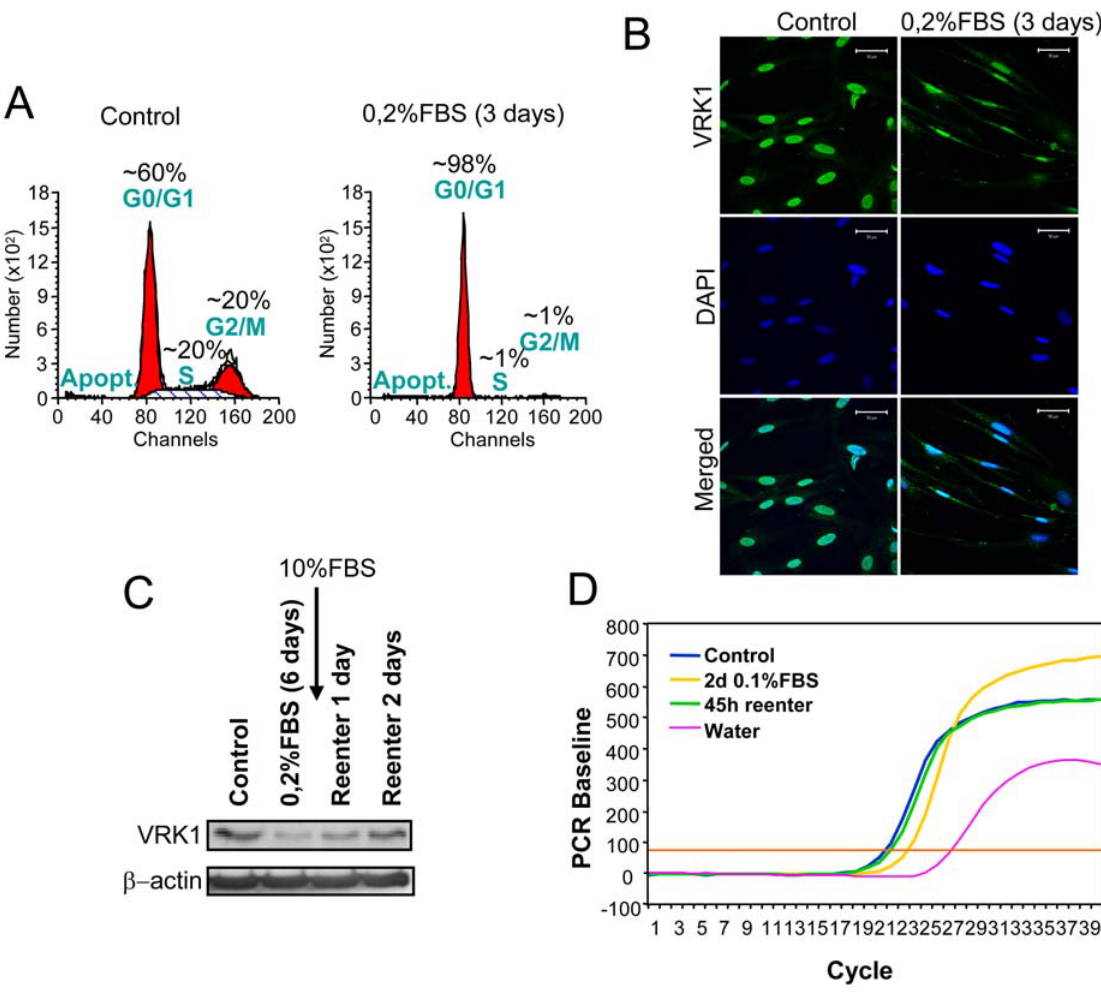
Figure 1. VRK1 levels in different growth conditions of human fibroblasts. (A). Flow cytometry profile of WS1 cell cycle in non-synchronized (left) and serum starved cells (right). (B). Nuclear localization of VRK1 and morphology of WS1 cells in non-synchronized and starved WS1 cells. Endogenous VRK1 protein was detected with a specific polyclonal antibody (VE1) in the cell nuclei. The size bar represents 50 m m. (C). Level of VRK1 endogenous protein determined in an immunoblot. (D). Change in VRK1 gene expression by qRT-PCR upon withdrawal or addition of serum to the cell culture. These experiments were independently performed three times.